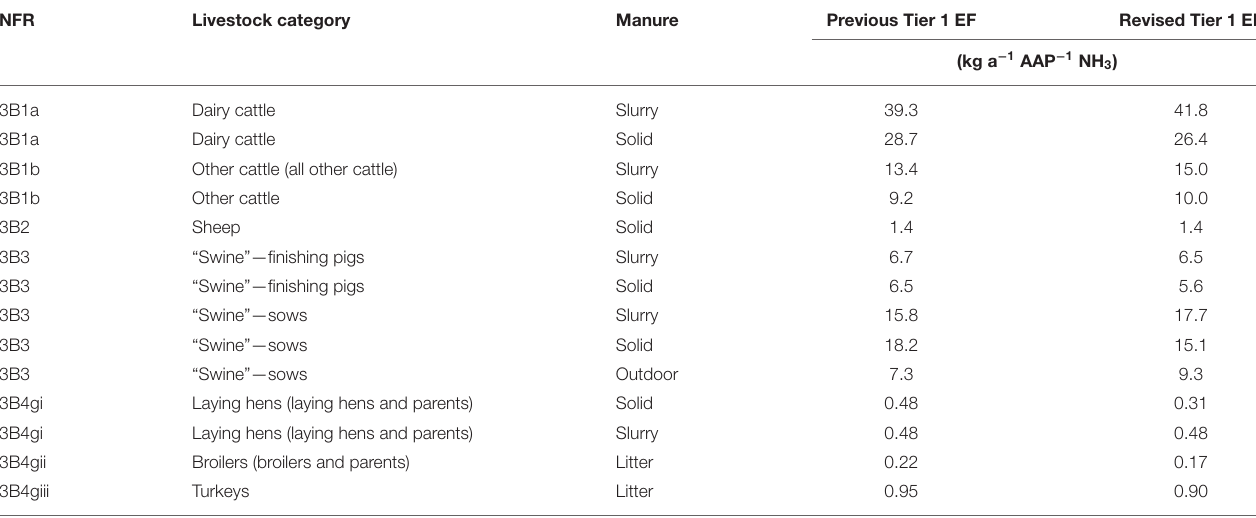
TABLE 9 | Existing guidebook emission factors (European Environment Agency, 2016) and revised emission factors. NFR Livestock